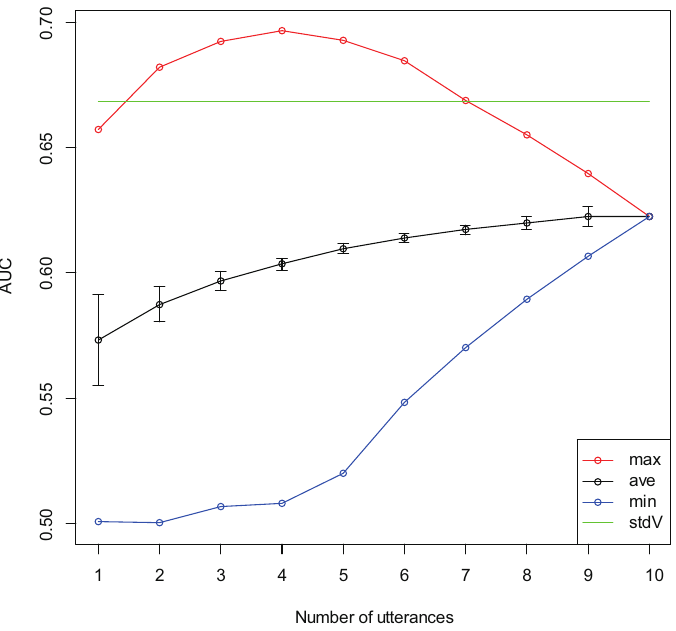
Figure 5. Healthy group/depressive group discrimination accuracy for each number of utterances. The results obtained for analyzing the differences from standard vitality for the number of utterances k = ( 1, 2, . . . , 10 ) are displayed in Figure 6. The red and blue dots respectively represent the largest and smallest differences in the obtained difference from standard vitality. The green dots represent differences obtained from the combination of utterances that gave the maximum AUC. The black dots represent the average of the difference, and the upper and lower bars represent the standard error. In addition, the combinations of utterances that gave the maximum/minimum differences for up to six utterances are presented in Table 4.